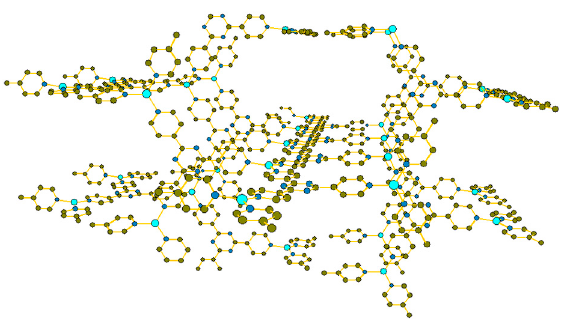
Figure 1. Depth perspective of Cu(tpt)BF 4 ·¾H 2 O skeletal framework. Hydrogen atoms omitted for clarity.